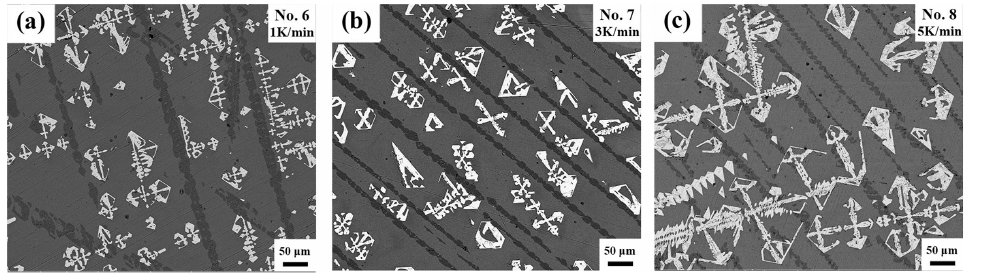
Figure 8: SEM images of No. 6 to No. 8 test-run slag samples under the condition of keeping endpoint temperature at 1453 K with holding time in 60 min at three cooling rates of 1, 3, and 5